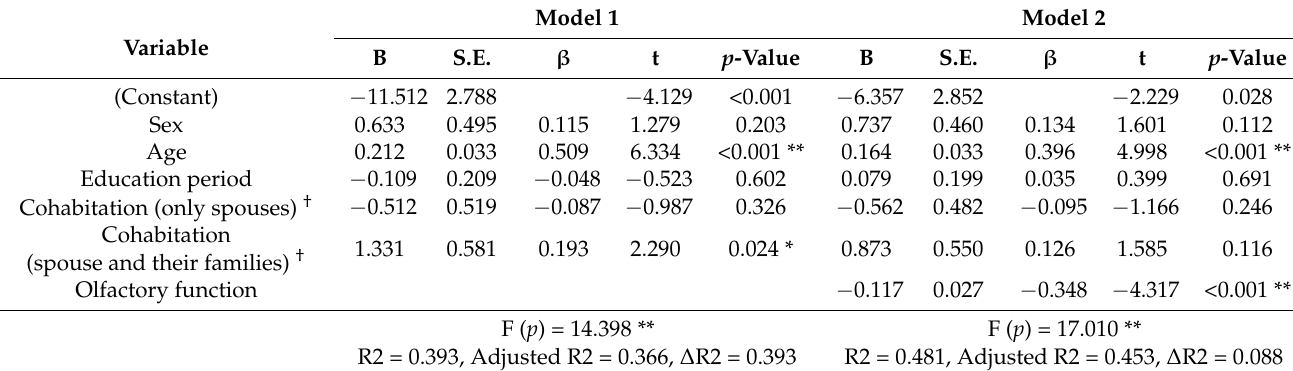
Table 4. Factors associated with cognitive impairment in older persons with cognitive